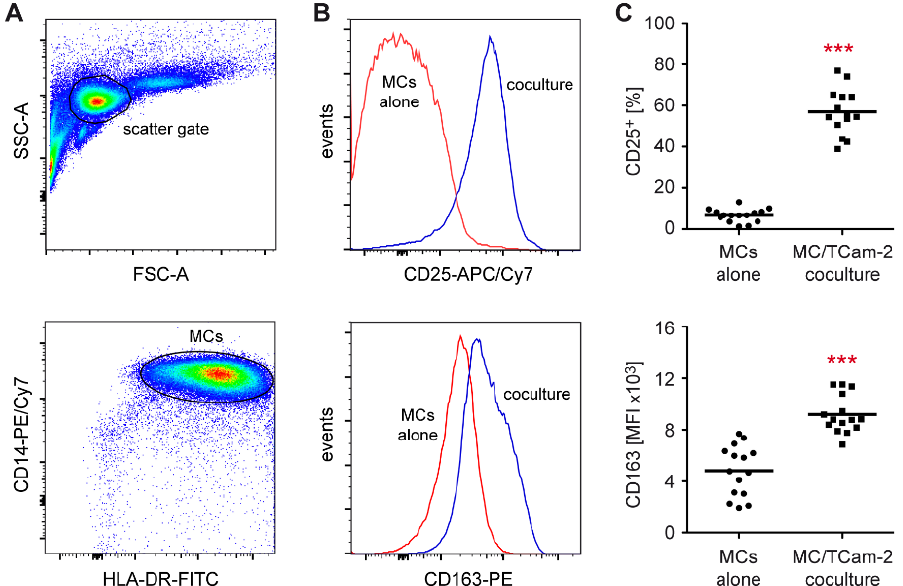
Figure 3. Flow cytometric analysis of peripheral blood monocytes cocultured with TCam-2 cells. Monocytes (MCs) were isolated from PBMC of healthy blood donors using magnetic cell sorting and cultured in 6-well plates either on a monolayer of TCam-2 cells or alone for 24 h. MCs were collected and stained with fluorochrome-conjugated monoclonal antibodies. ( A ) Exemplary gating strategy for MC analysis. Relevant cells were first identified on the basis of their forward and sideward scatters, followed by gating for MCs based on their co-expression of CD14 and HLA-DR. ( B ) Histograms of CD25 (upper panel) and CD163 (lower panel) surface expression on MCs either cultured alone (red line) and cocultured with TCam-2 cells (blue line). ( C ) Quantification of the percentage of CD25 + MCs (upper panel) or the MFI of CD163 (lower panel) in each condition. N = 14–15; PBMC were obtained from 5 healthy volunteers. Statistical analysis was performed by unpaired t -test (***: p < 0.001).